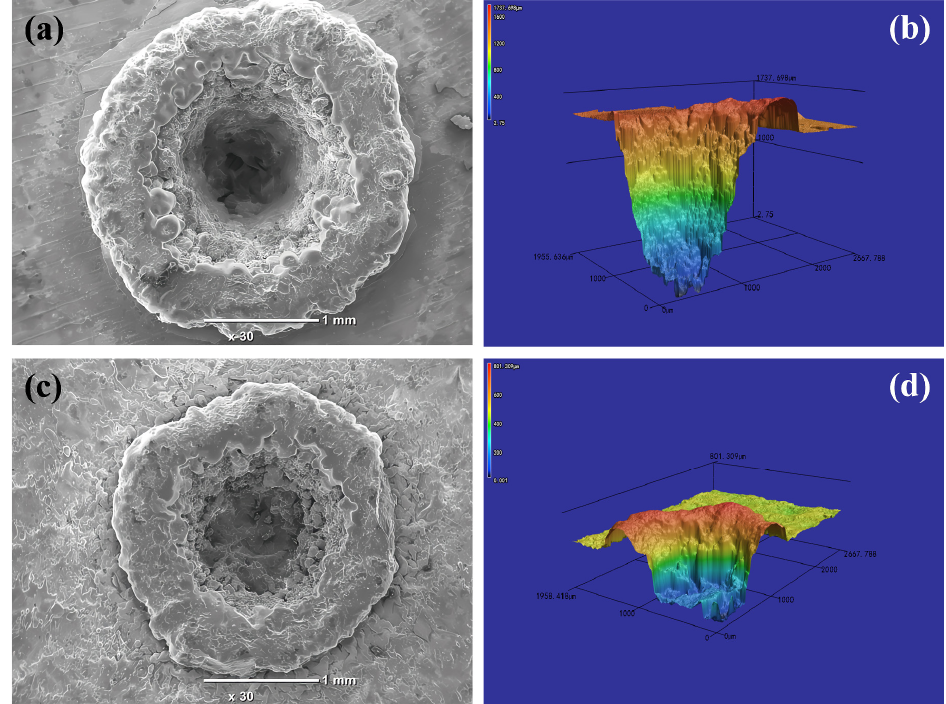
Figure 7. Morphologies of TC4 alloy ( a,b ) and TiCrNiVSi 0.1 alloy coating ( c,d ) after laser ablation. Table 7. Ablation pit size parameters of TC4 alloy and TiCrNiVSi0.1 alloy coatings after laser ablation. Pit Size Parameter